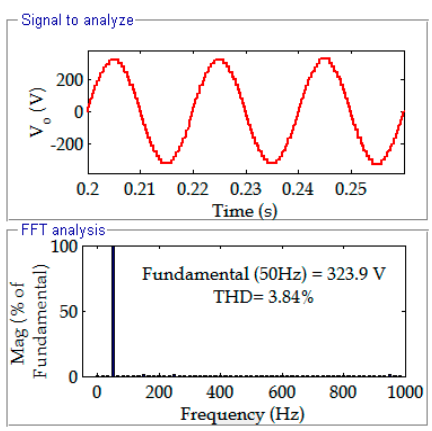
Figure 10. Harmonic spectra of 1 − level MLI.